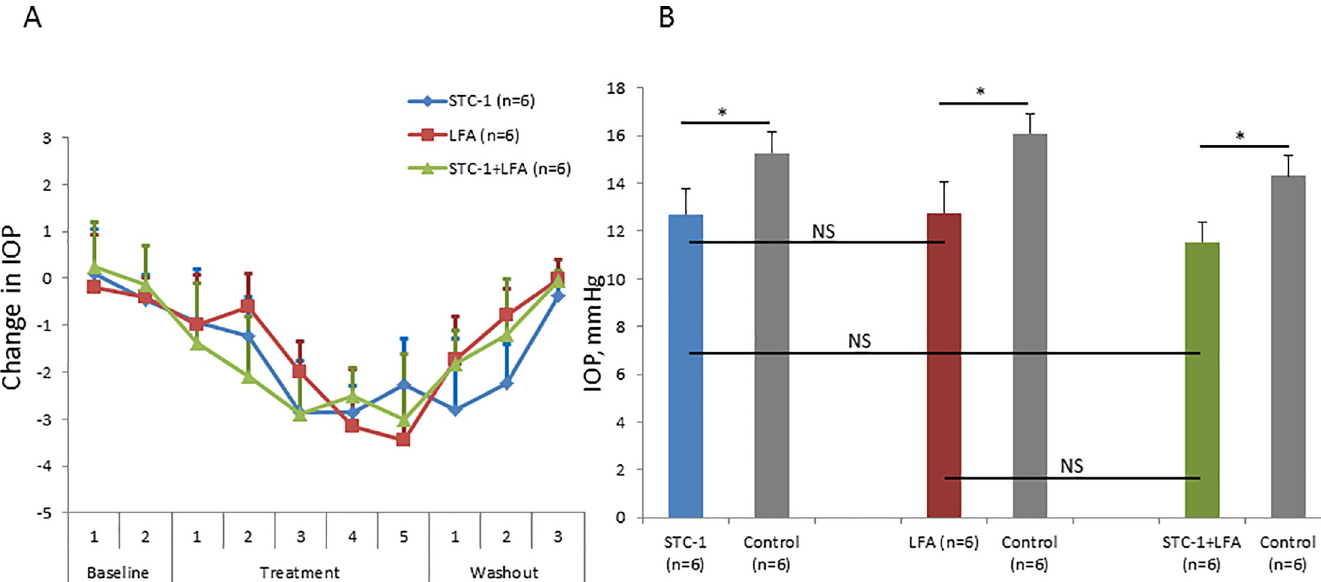
Fig 1. STC-1 is equivalent and non-additive to LFA for IOP reduction in C57BL/6J wild-type mice. A) After baseline IOP measurements, STC-1, LFA, and a combination of STC-1 and LFA all reduced IOP and returned to baseline following washout. B) At the maximal reduction of IOP with treatment (average of treatment day 4 and 5), LFA (10 − 4 M), STC-1 (0.5 μ g/ μ L) and LFA/STC-1 combination therapy in C57BL/6J mice all showed significant IOP reduction when compared to the contralateral vehicle control eye. However, no statistical difference in IOP reduction was seen when treatment groups were compared to one another. Sample size of all conditions was n = 6. NS = not significant. Error bars represent average ± standard deviation. � P < 0.05.